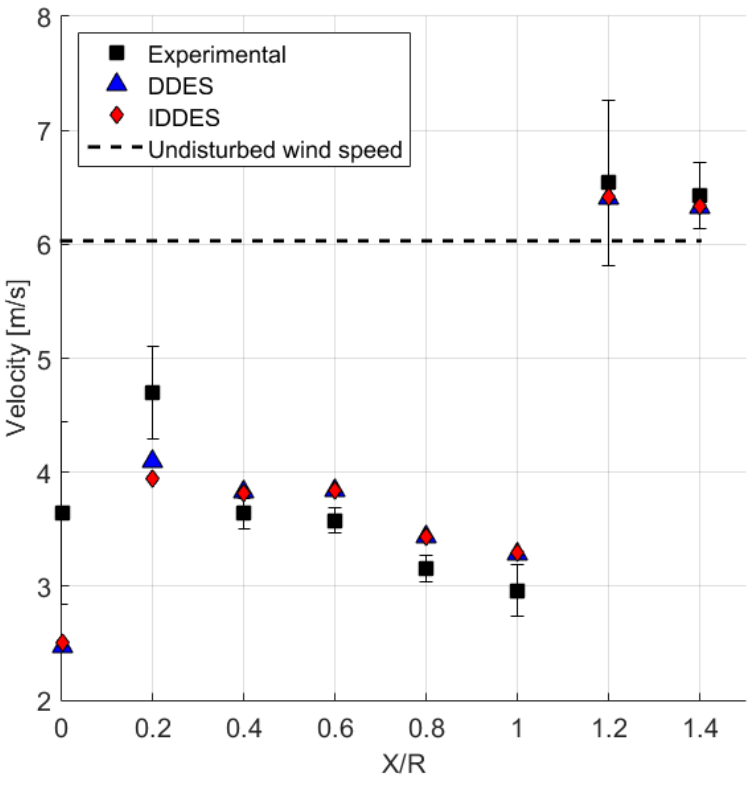
Figure 9. Average longitudinal velocity in the wake at 0.5D downstream. Average for one